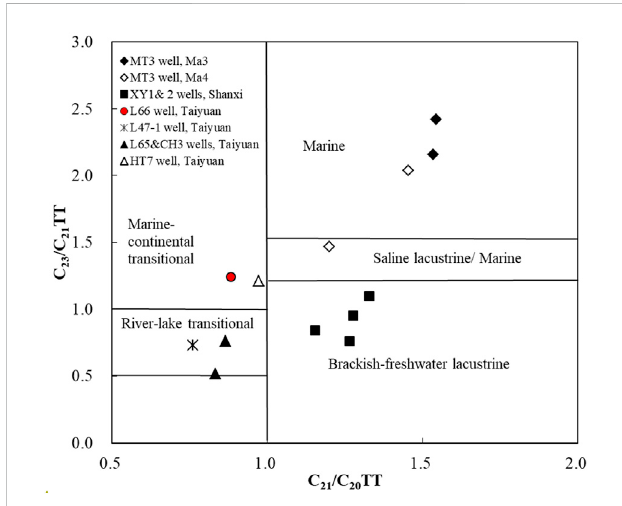
Environmental identi fi cation for the samples from the Ordovician and Permian in the Ordos